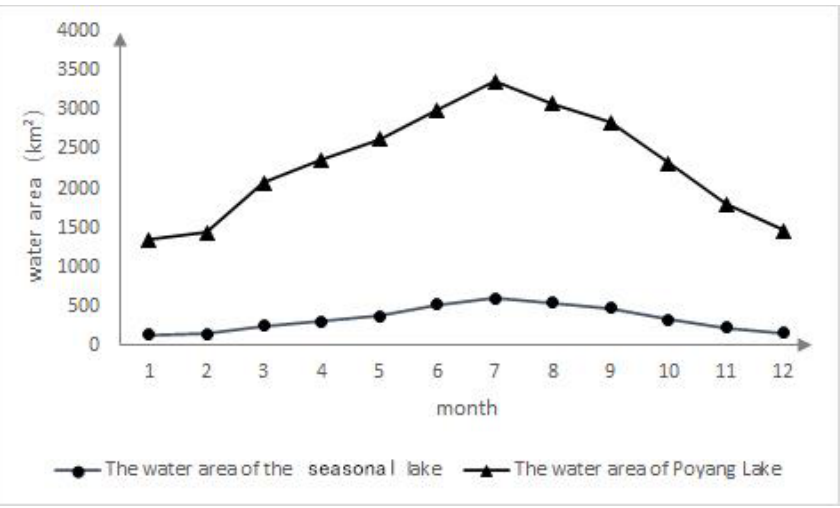
Figure 8. Comparison of changes in water area between seasonal lakes and Poyang Lake.